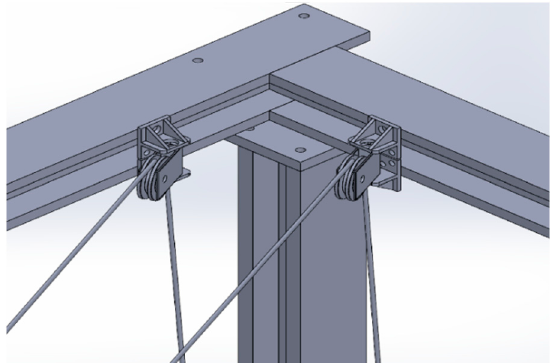
Figure 8. Arrangement of pulleys on the cargo hold structure.